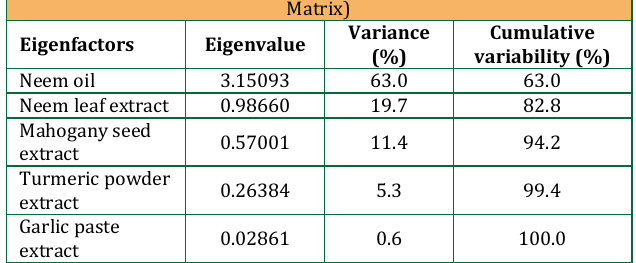
Table 7: Eigenvalues, percent of variance and Cumulative percent of variance of different plant extracts in PCA (Based on Correlation